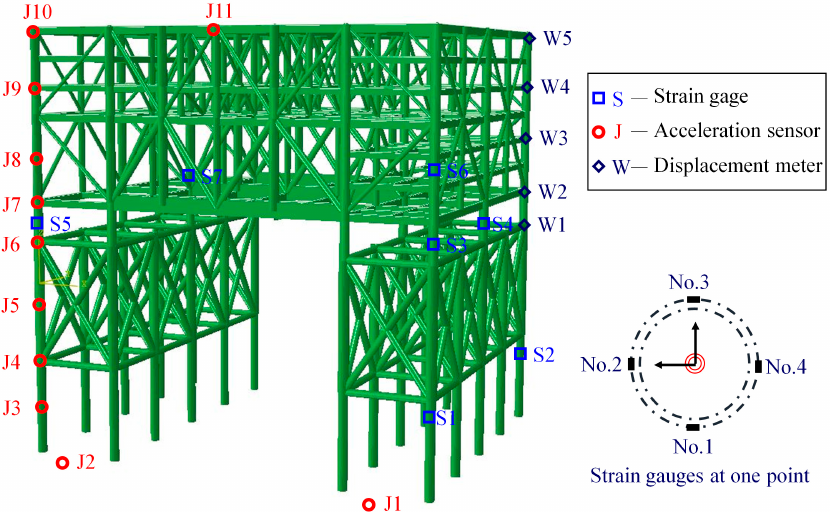
Figure 8. Measurement position of the earthquake response at key nodes of the electrical